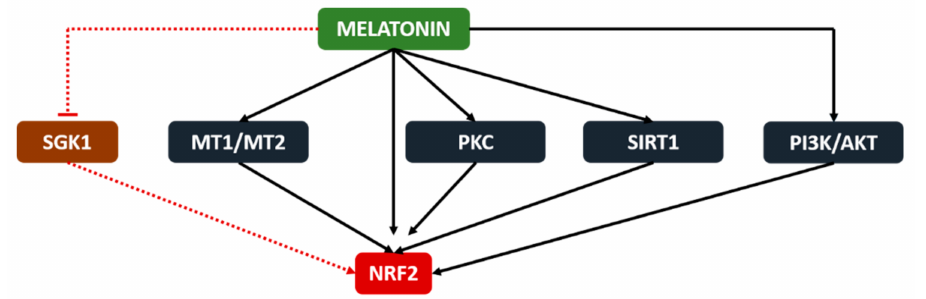
Figure 3. Melatonin stimulates NRF2 via the melatonin receptors (MT1 and MT2), SIRT1 and PI3K/AKT pathways in nontumorigenic cells while inhibiting the SGK1-mediated upregulation of NRF2 in tumorigenic